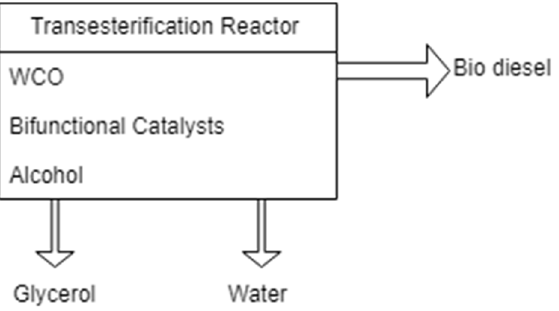
Figure 4. Schematic of the transesterification process with bifunctional catalysts.